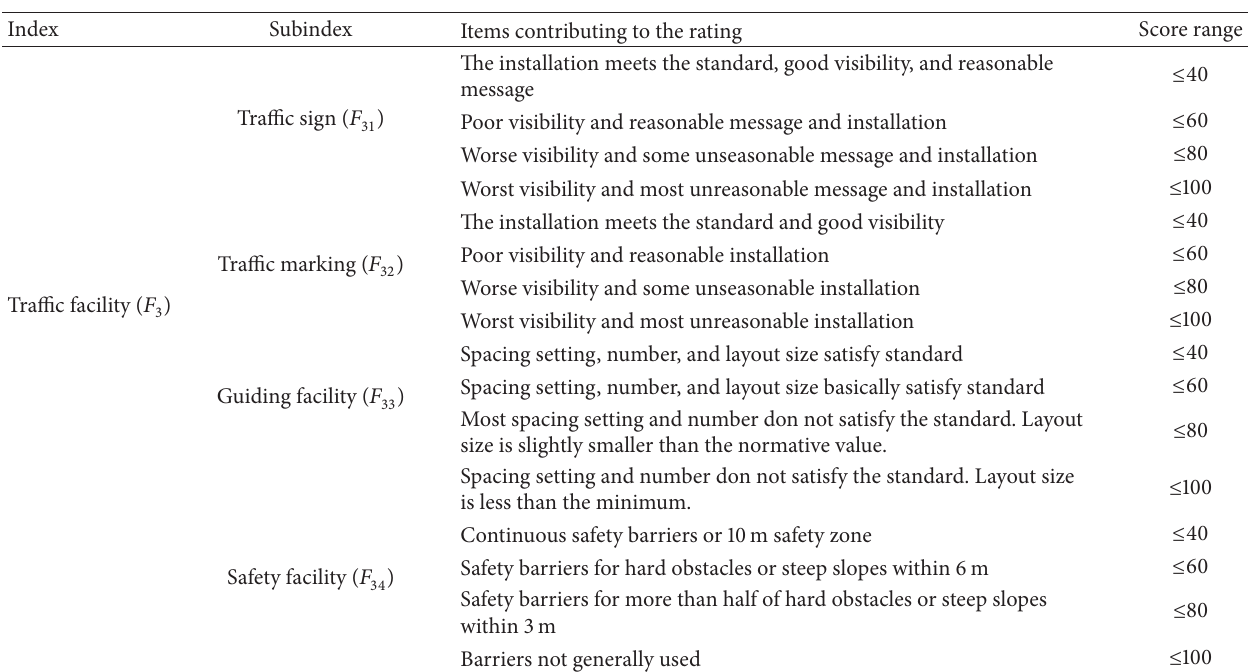
Table 13: Survey form for traffic